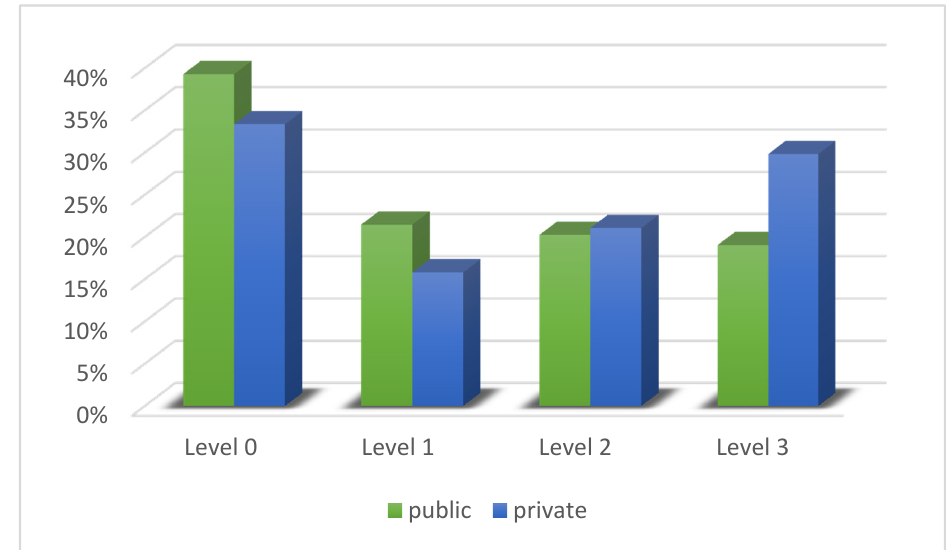
Table 5. Basic descriptive statistics for the number of meetings, depending on the type of supporting partner.